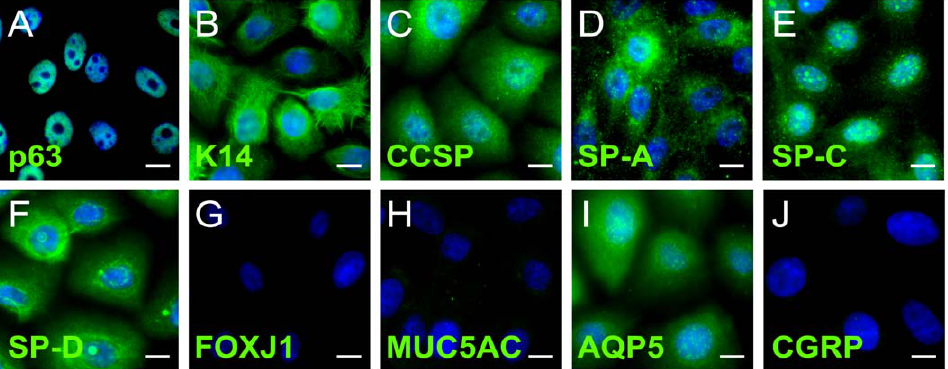
Figure 3. Immortalized HBEC3s Simultaneously Express Markers of Multiple Cell Types of the Lung. Immunofluorescence staining of HBEC3 KTs cultured as 2D monolayer in differentiation media for two days demonstrates capacity of HBEC3 KTs to express markers from multiple lung cell types while actively proliferating. (A) p63. (B) K14. (C) CCSP. (D) SP-A. (E) SP-C. (F) SP-D. (G) FOXJ1. (H) MUC5AC. (I) AQP5. (J) CGRP. DAPI, blue. Scale bars 10 m m. Results are representative of five independent experiments.